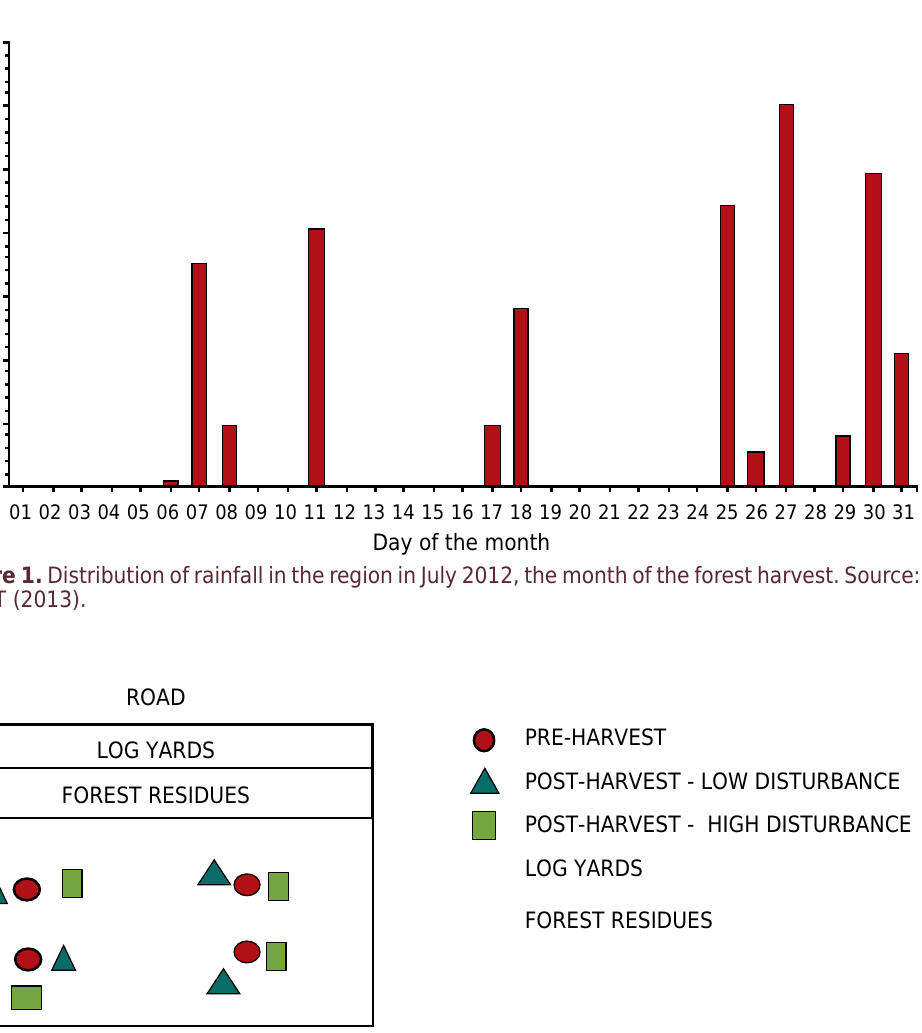
Figure 2. Sketch of the distribution of soil conditions post-harvest.